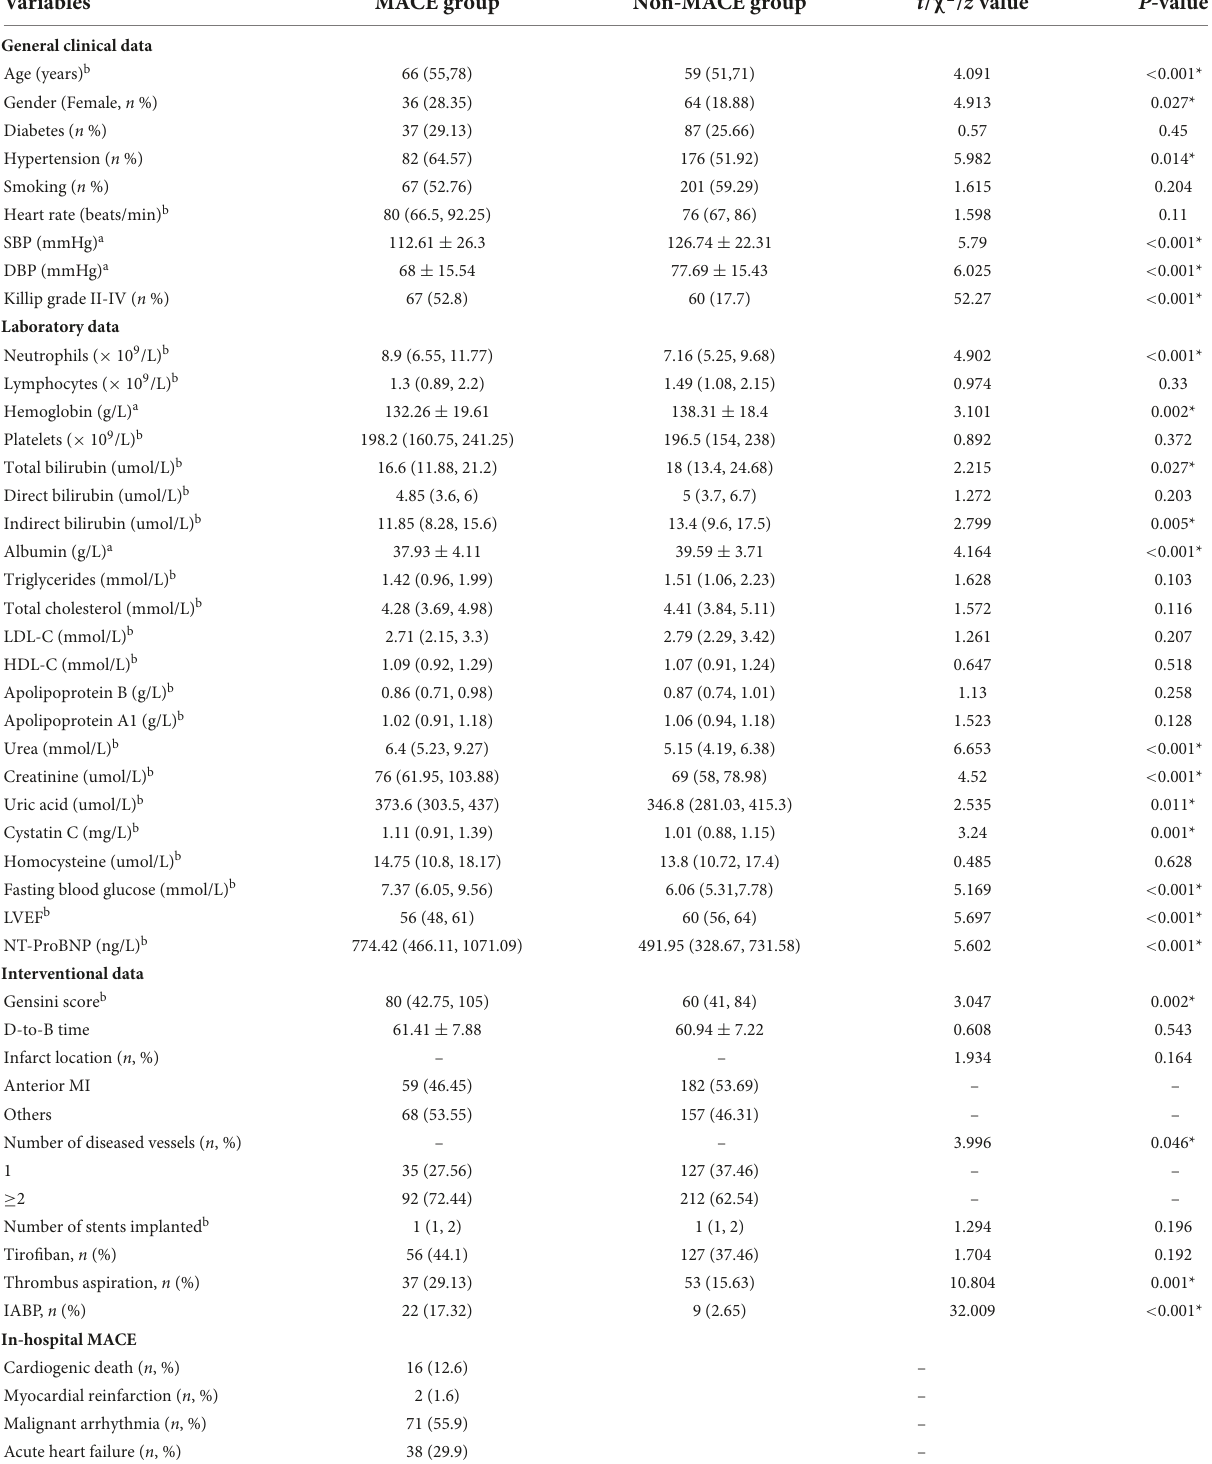
TABLE 1 Comparison of general clinical data between major adverse cardiovascular events (MACE) group and non-MACE group. Variables MACE group Non-MACE